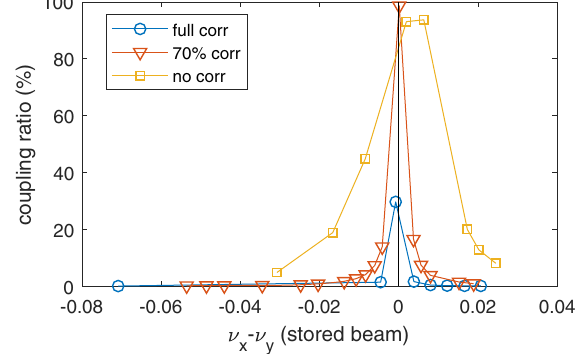
FIG. 4. Coupling ratio (stored beam) for the three cases.